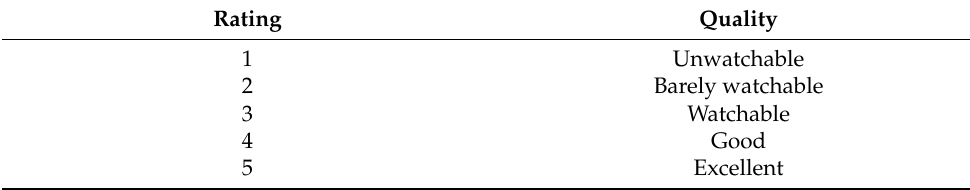
Table 22. Image quality ratings.